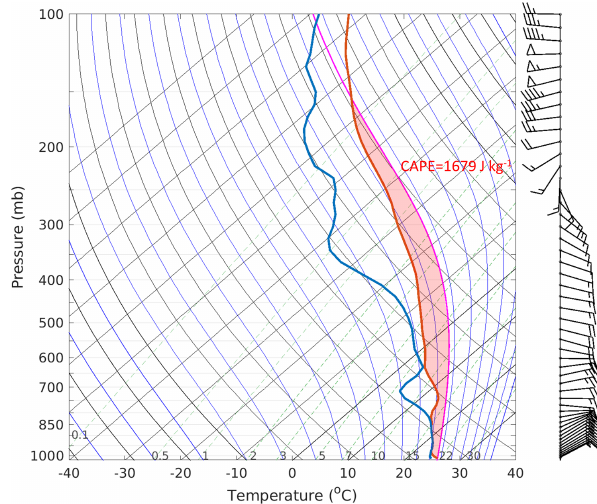
Figure 1. Initial atmospheric profiles for the idealized simulations. The blue line represents the dew point temperature, the red line rep- resents the environment sounding (temperature), and the magenta line represents the parcel lapse